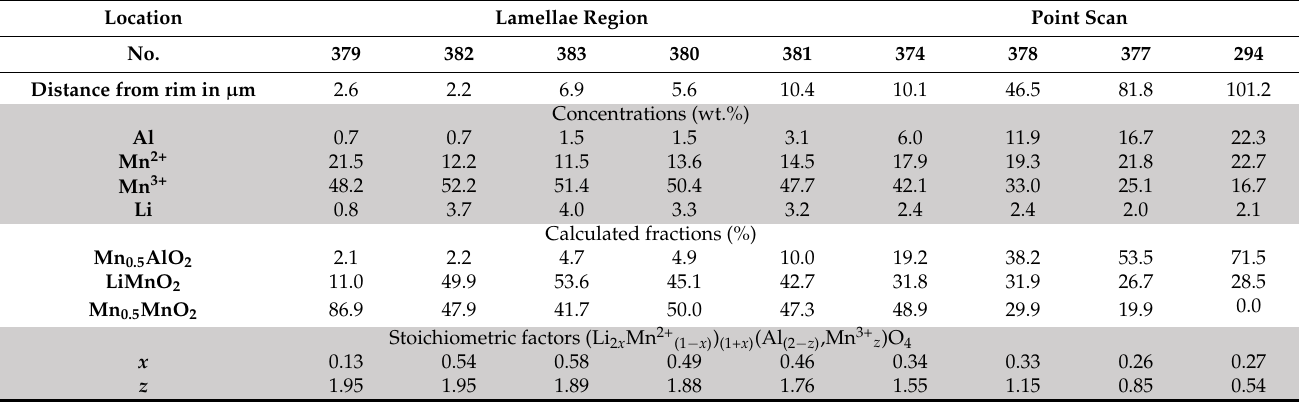
Table 4. Spinel formulas, calculated with the Al and Mn concentrations of Table 3, sorted in ascending order according to the Al concentration. The Mn 2+ /Mn 3+ -ratio was calculated using the total measured Mn concentration in Table 3. The Li concentration is derived from the calculated fraction of LiMnO 2 . In the first section of the table, the concentrations of the elements are given in weight percent. In the second section, the calculated fractions of the different virtual components in percent are presented. In the last section, the stoichiometric ratio of the formula (Li (2 x ) Mn 2+ (1 − x ) ) 1+ x (Al (2 − z ) ,Mn 3+ z )O 4 is presented. The distance from the lamellae region points to the nearest rim is given. Regarding the point scans, a virtual line is drawn through all points to the left rim. The distances are given from each point to the intersection of this line with the